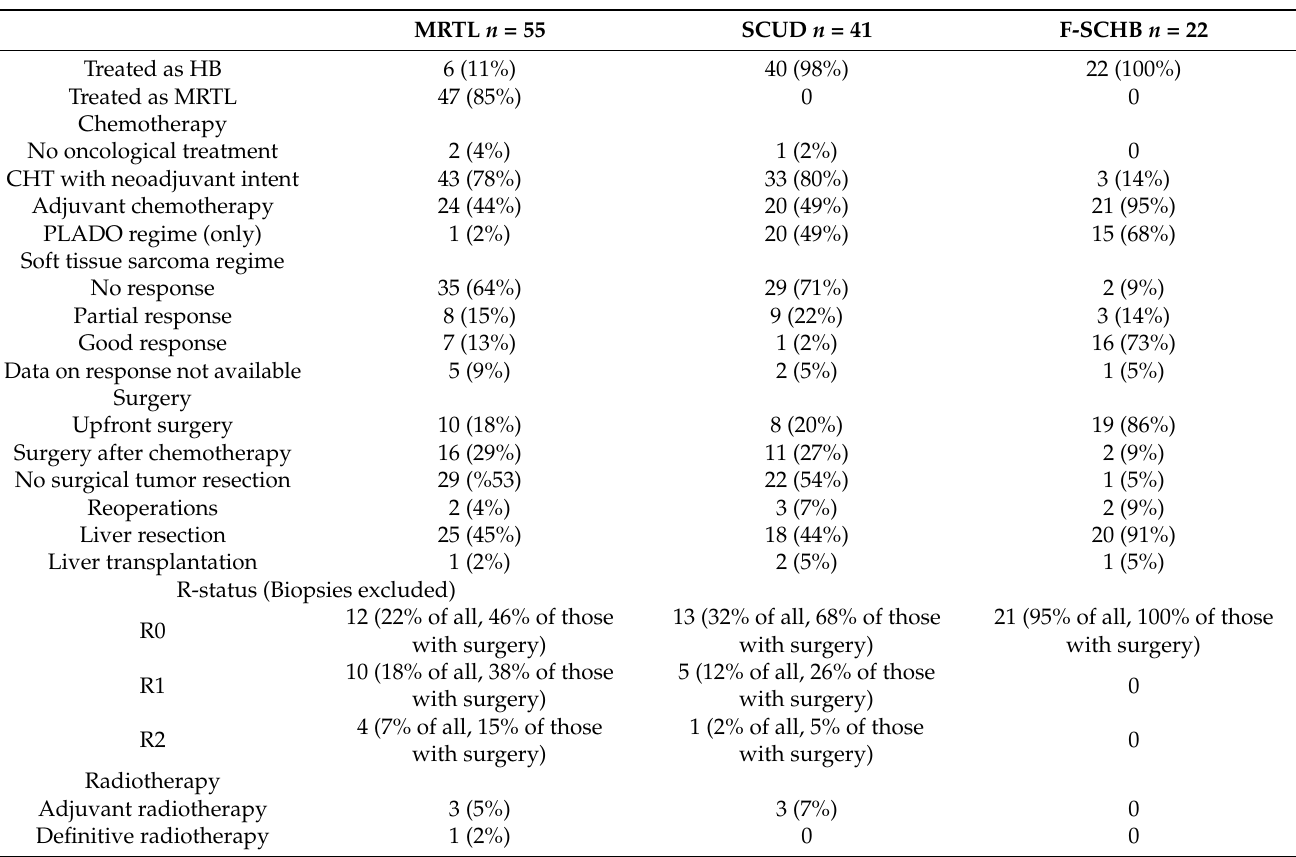
Table 4. Therapy and details of surgery.